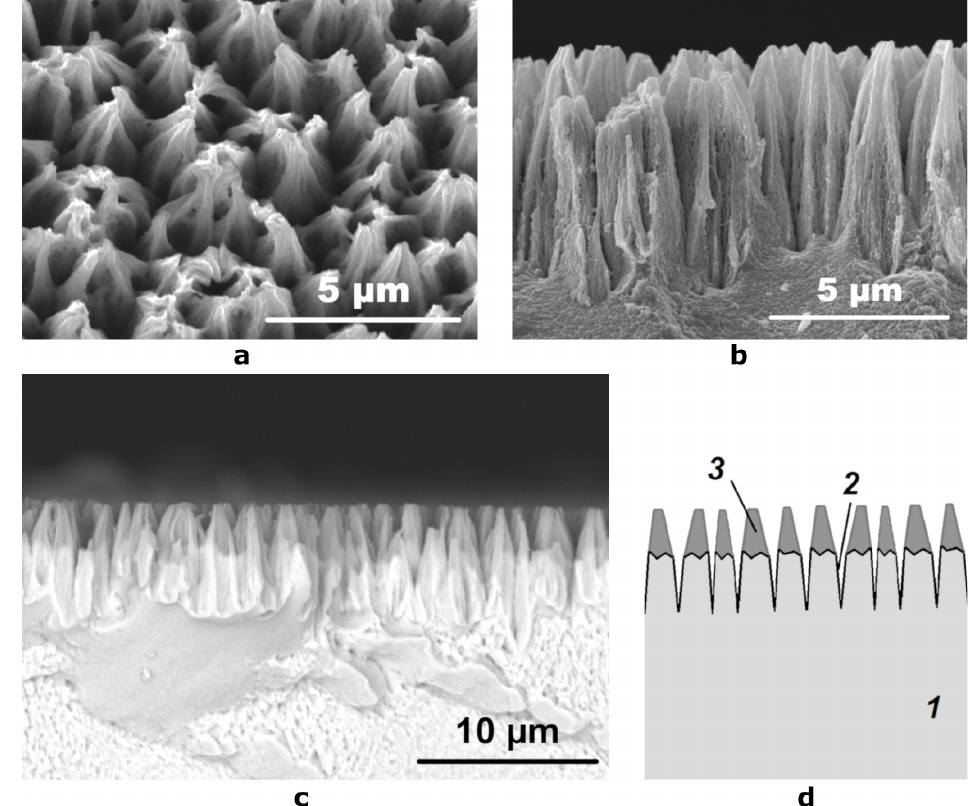
Figure 2. SEM micrographs of ( a ) the etched surface at an angle of 10° and ( b ) its cross section obtained using a secondary electron detector; ( c ) a cross section SEM image obtained using a reflected electron detector; ( d ) schematic representation of the cross section of the etched coating: 1—Ni-P coating, 2—hollows formed during etching, 3—layer of conical particles containing light elements.